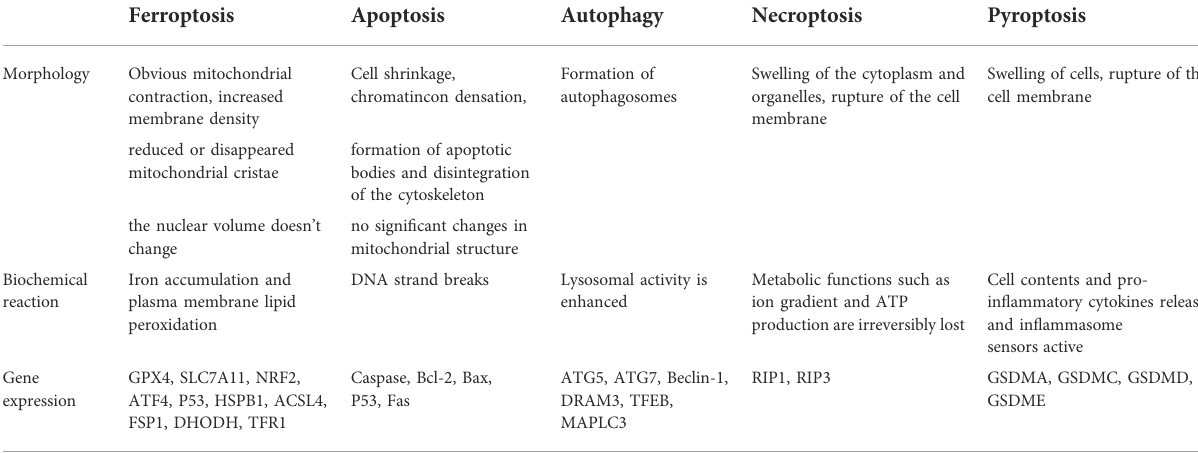
TABLE 1 The difference between ferroptosis, apoptosis, autophagy, necroptosis, and